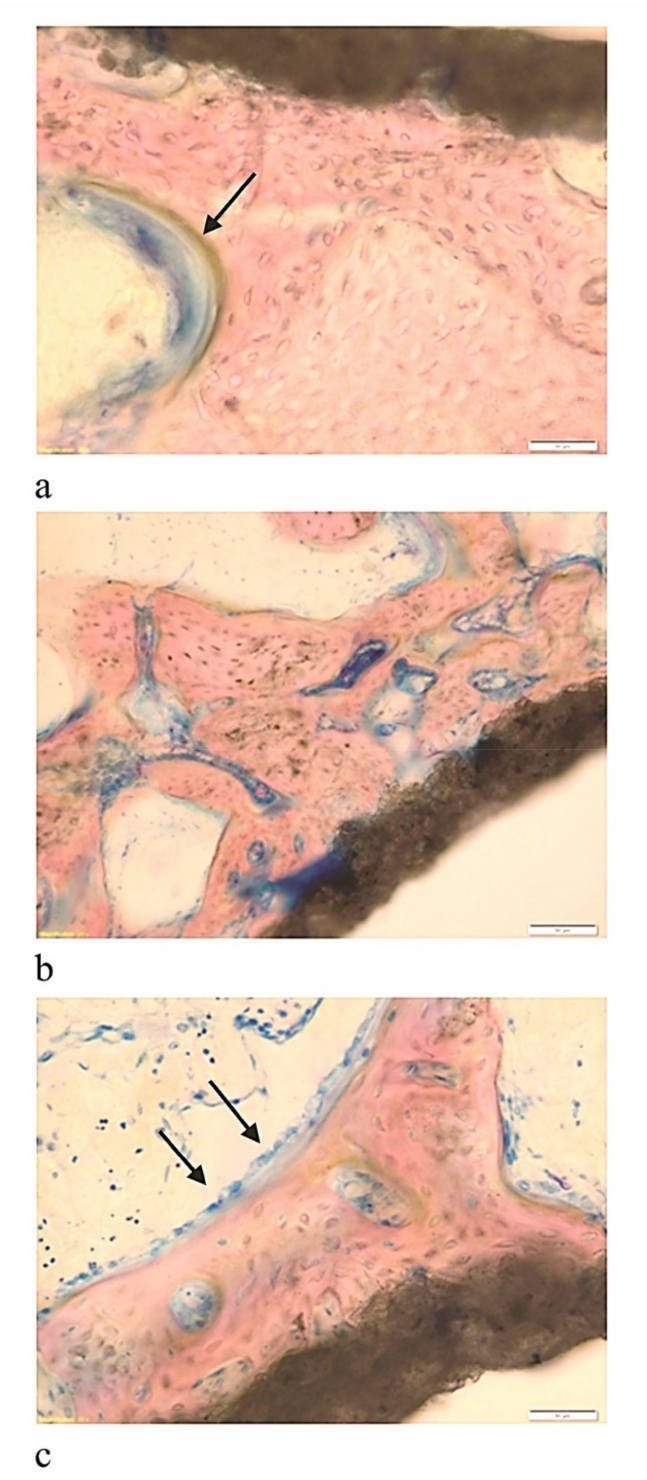
Figure 2. Histological sections of a Ti-HA + BMSC + PRP implant after 2 weeks. Stain: Stevenel’s blue and Van Gieson’s picro-fuchsin. Magnification 20 × . Calcified bone stains a bright pink. Osteoid stain bright green; osteoblasts stain blue. ( a ) Osteoid-like tissue layer (dashed arrow); ( b ) Extensive new bone formation as osteoblast-like cells; ( c ) Cuboidal osteoblast-like cells (continuous